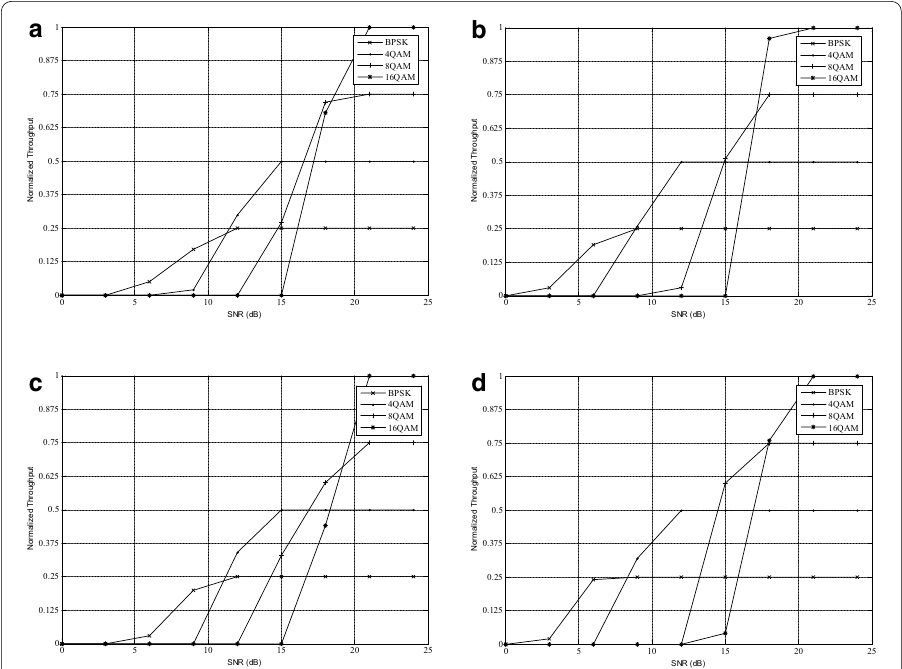
Fig. 5 Throughput performance comparison under different modulation modes. a Comparison for adaptive modulation based on SNR with FTL-BED, b comparison for adaptive modulation based on SNR with ATL-BED, c comparison for adaptive modulation based on SMSE with FTL-BED, d comparison for adaptive modulation based on SMSE with